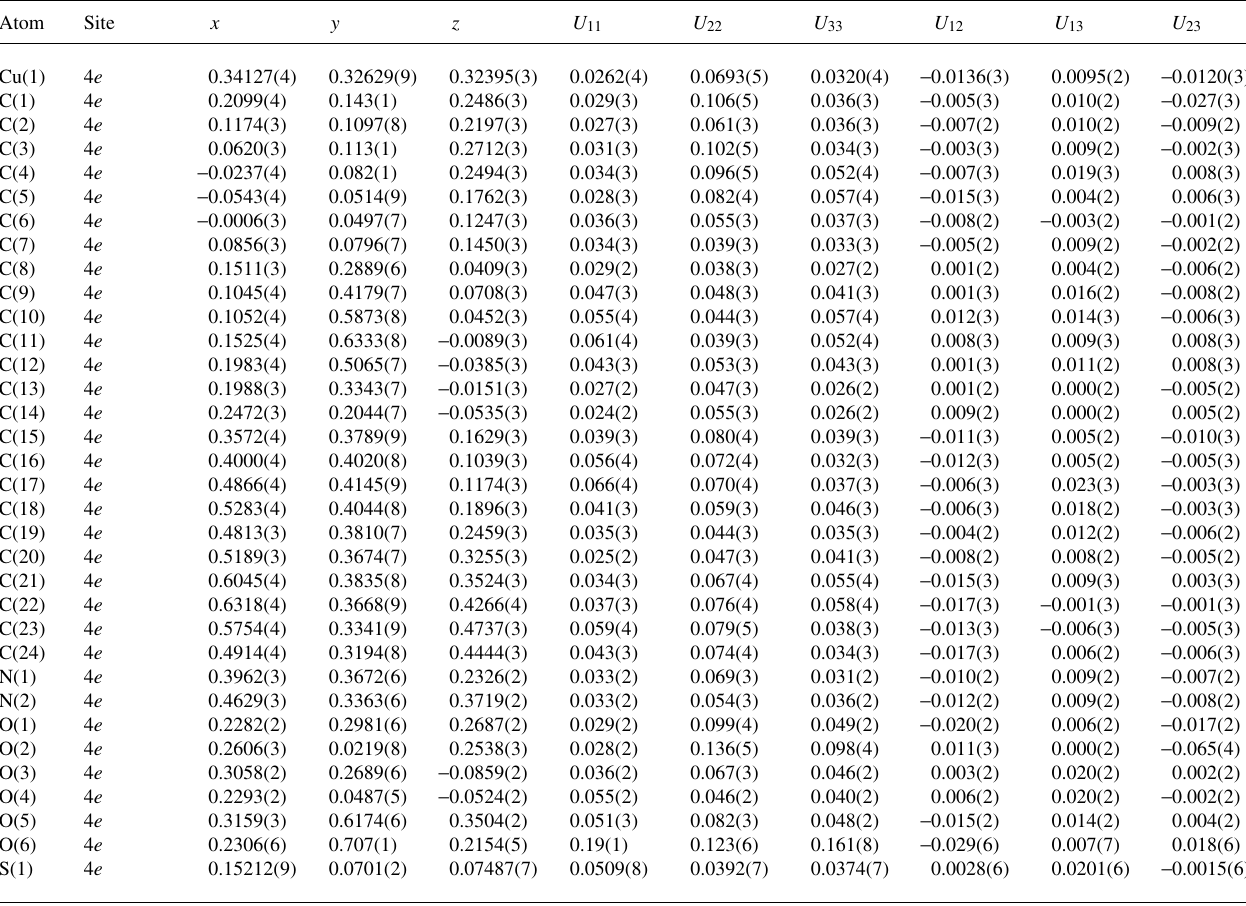
Table 3. Atomic coordinates and displacement parameters (in Å 2 ) .